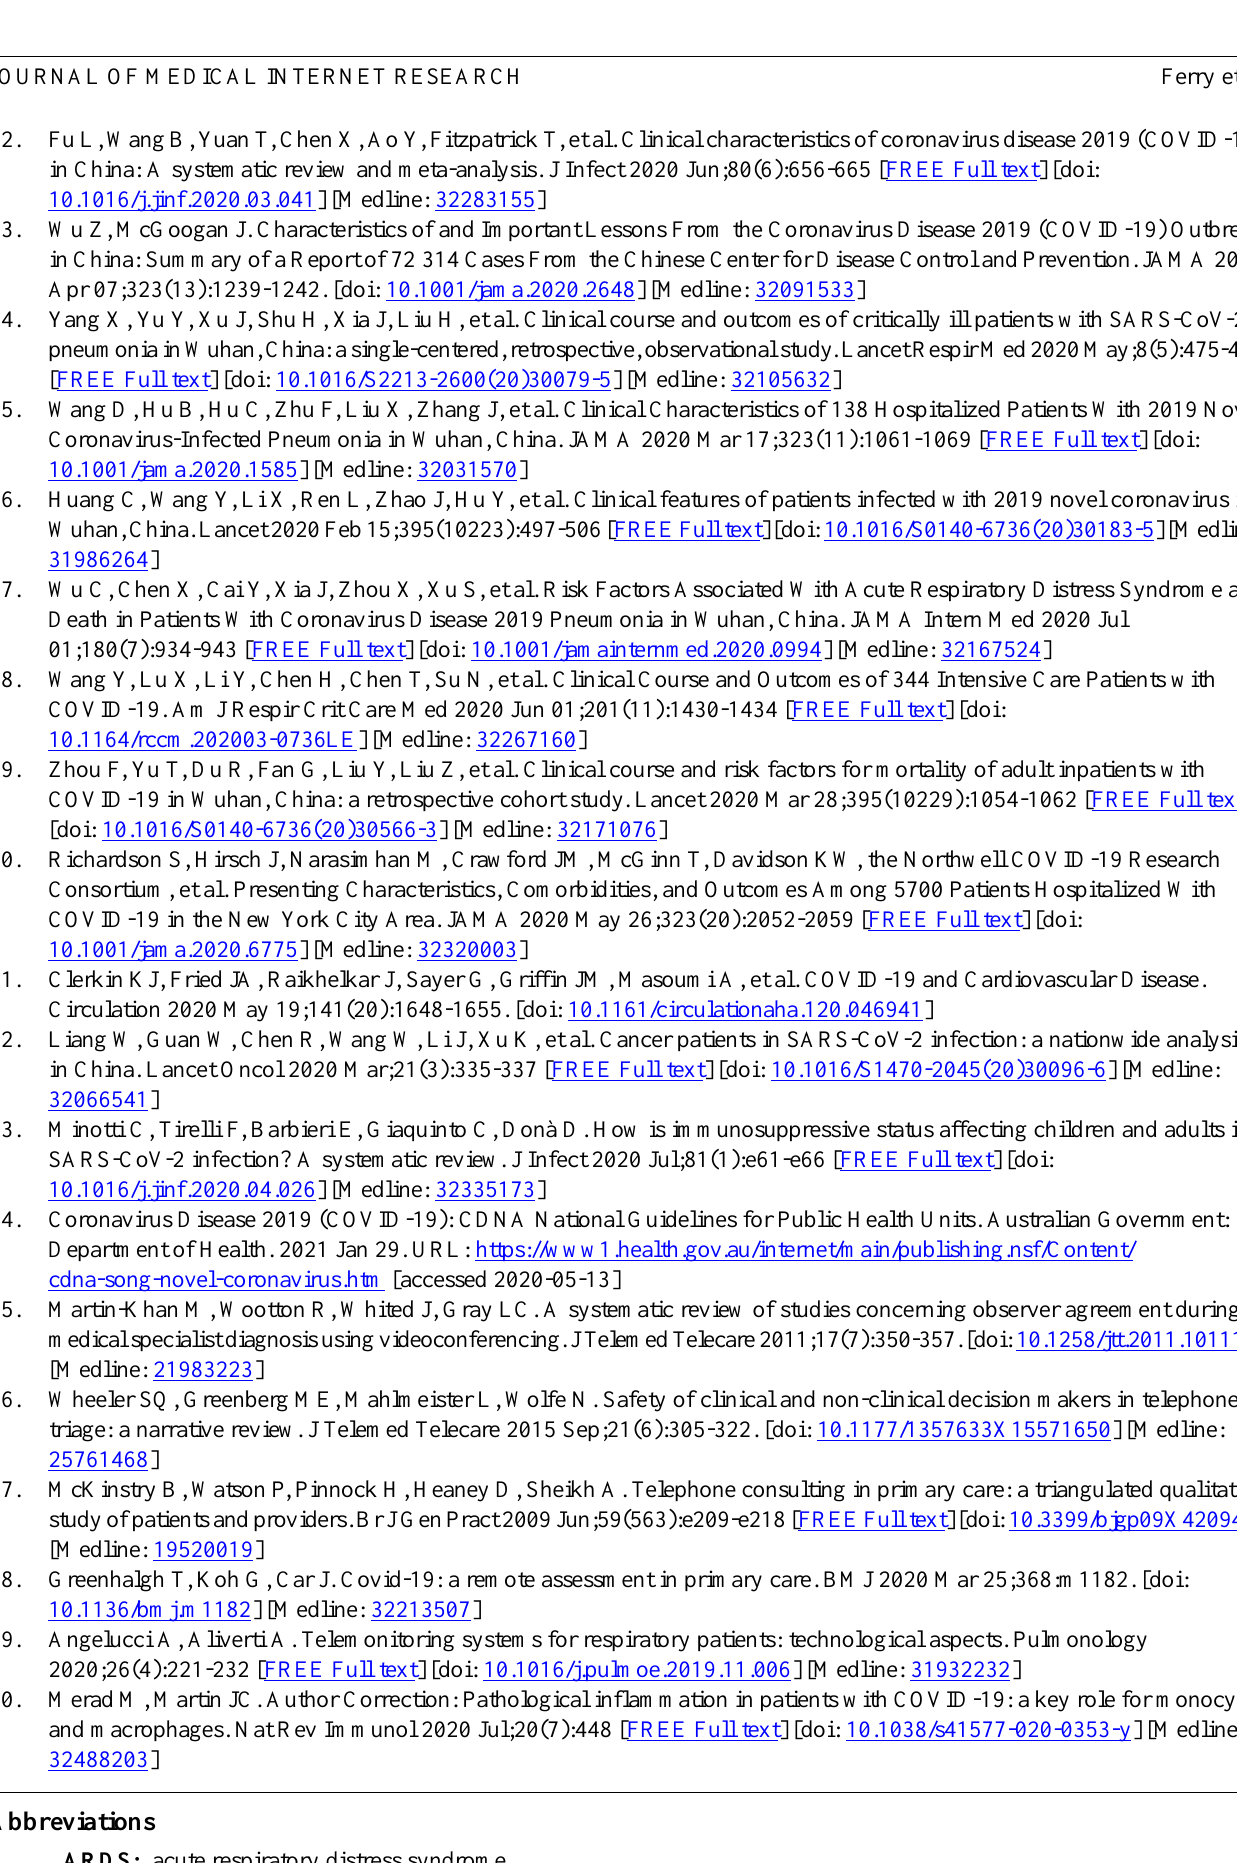
ARDS: acute respiratory distress